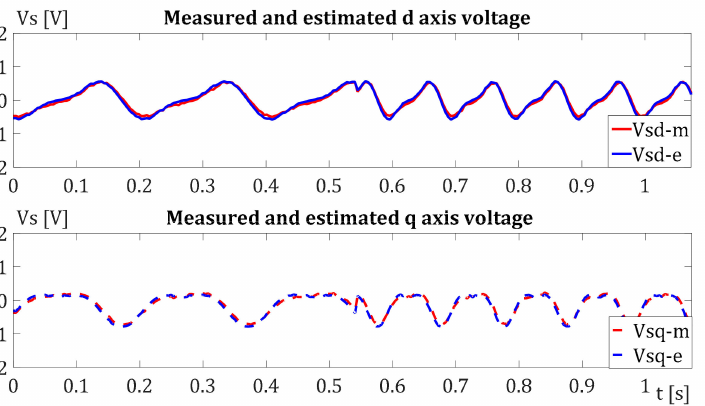
Figure 9. Experimental results for measured and estimated voltage (parameters of voltage estimator tuned